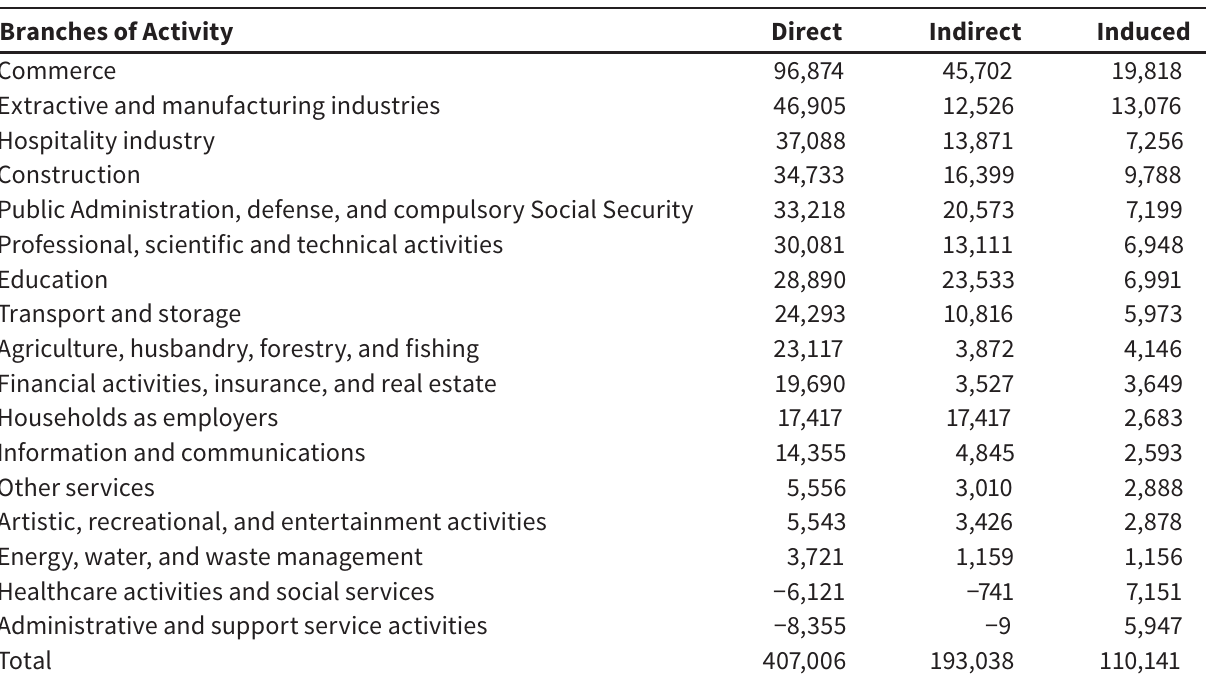
Impact on sectoral employment associated with the full integration of persons with disabilities in the workforce,